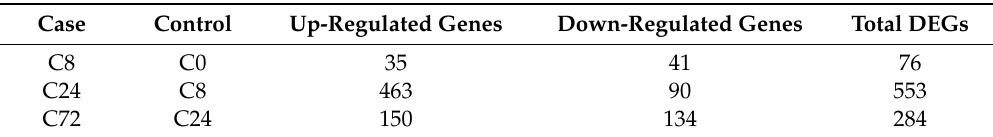
Table 2. Summary of identified DEGs.